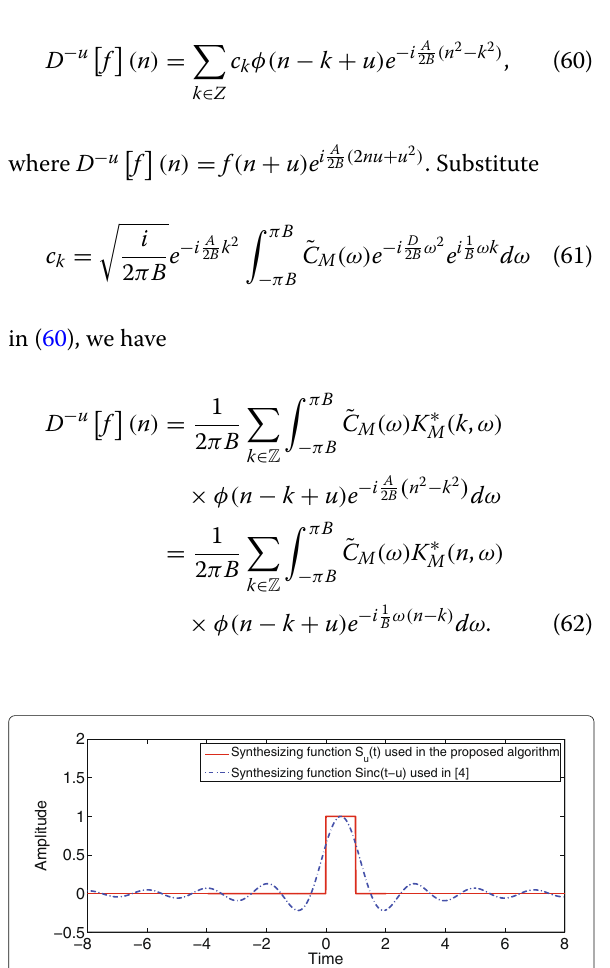
(cid:29) δ( t − k ) k ∈ Z c [ k ]